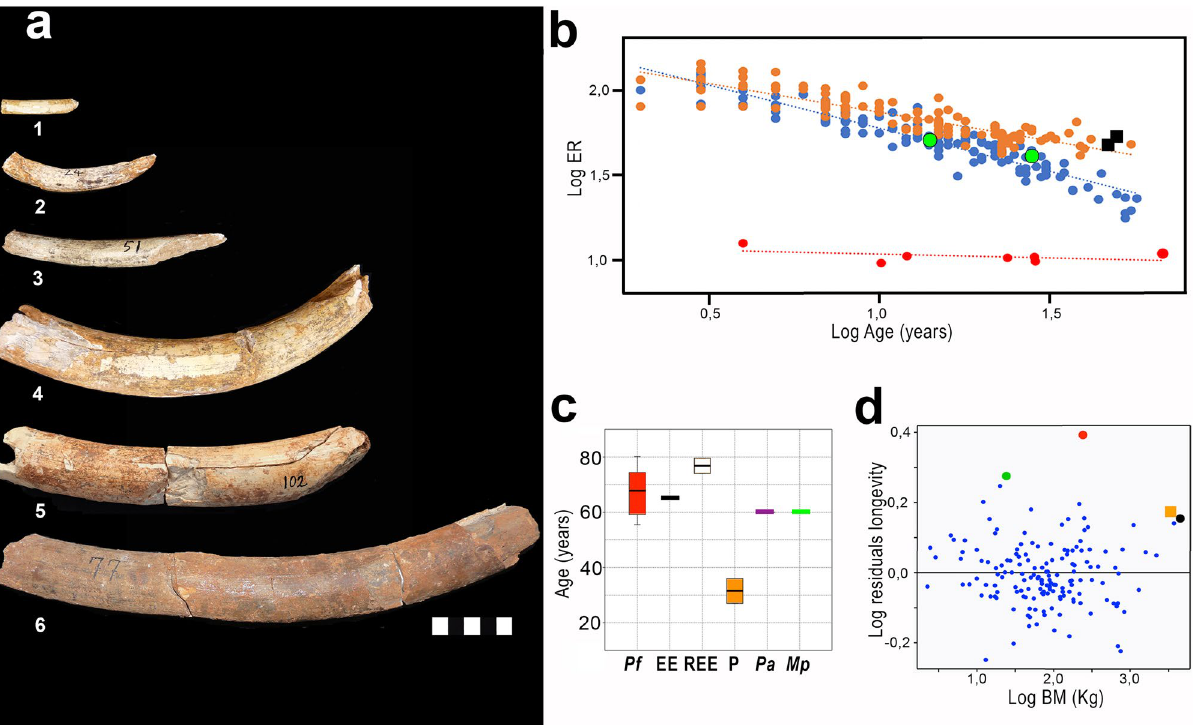
Figure 4. Tusk growth patterns of P. falconeri . ( a ) Spinagallo tusks sample analysed. 1: CAT-5; 2: CAT- 24; 3: CAT-51; 4: CAT-100; 5: CAT-102; 6: CAT-77-76-78. Graphic scale 5 cm. (Supplementary material 5, Supplementary Table 5). ( b ) changes in ER over ontogeny (log-transformed age (x) and log of ER (y)) in L. africana 37 and P. falconeri . Blue dots: L. africana females (y = − 0.5116x + 2.291, R 2 = 0.88); orange dots: L. africana males (y = − 0.3402x + 2.2119, R 2 = 0.77); red dots: P. falconeri (y = − 0.0446x + 1.0793, R 2 = 0.22). Observe the low position of the P. falconeri tusk ER regression line and the low exponent, showing the small differences in ER between young and old individuals, which accounts for the stable ontogenetic growth pattern. Green dots L. africana specimens aged by Uno et al. 38 . Black squares correspond to tusks of M. primigenius 39 , M. columbi 40 and M. americanum 41 ( c ) Box-and-whisker plots comparing the lifespan inferred for P. falconeri ( Pf ) from the six tusks analysed, with the longevity values of extant elephants (EE) L. africana and H. maximus from AnAge data base 35 , and maximal records of longevity in extant elephants 42–46 (REE); (P) lifespan predicted for P. falconeri from body mass allometry 23–25 ; estimations of inferred lifespan for fossil large elephants P. antiquus 47 ( Pa ) and M. primigenius 47 ( Mp ). Horizontal lines denote the median, boxes the interquartile range (25–75 percent quartiles), and whiskers the maximum and minimum values; percentile ranks are computed by linear interpolation between the two nearest ranks. ( d ) Scatterplot of residuals of phylogenetic generalized least square regressions (PGLS) of body mass against longevity from the regression of ungulates (small blue dots); orange square: L. africana (body mass from Anage 35 ); black dot: E maximus based on body mass 35 ; red dot P. falconeri ; green dot M. balearicus from the Pleistocene of the island of Majorca 36 . Results of PGLS regression in Supplementary material